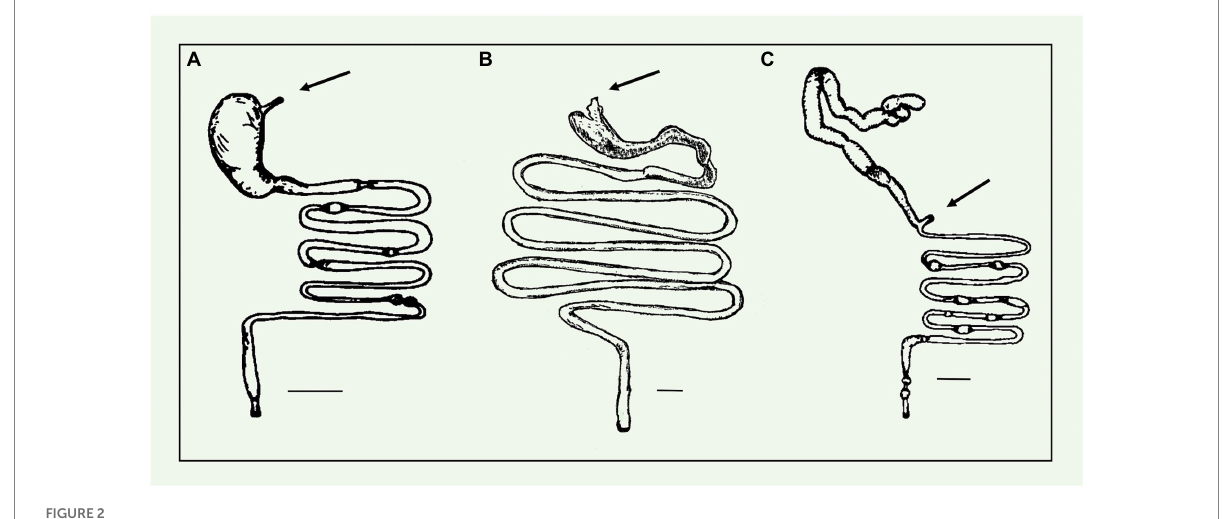
FIGURE 2 Gastrointestinal Tract. Schematic for gastrointestinal tracts of insectivorous (A) , frugivorous (B) , and sanguivorous (C) bats. Arrows point to the esophagus. Scale bar, 1 cm. (A,C) Modified from Stevens, (1980) and (B) modified from Tedman and Hall,